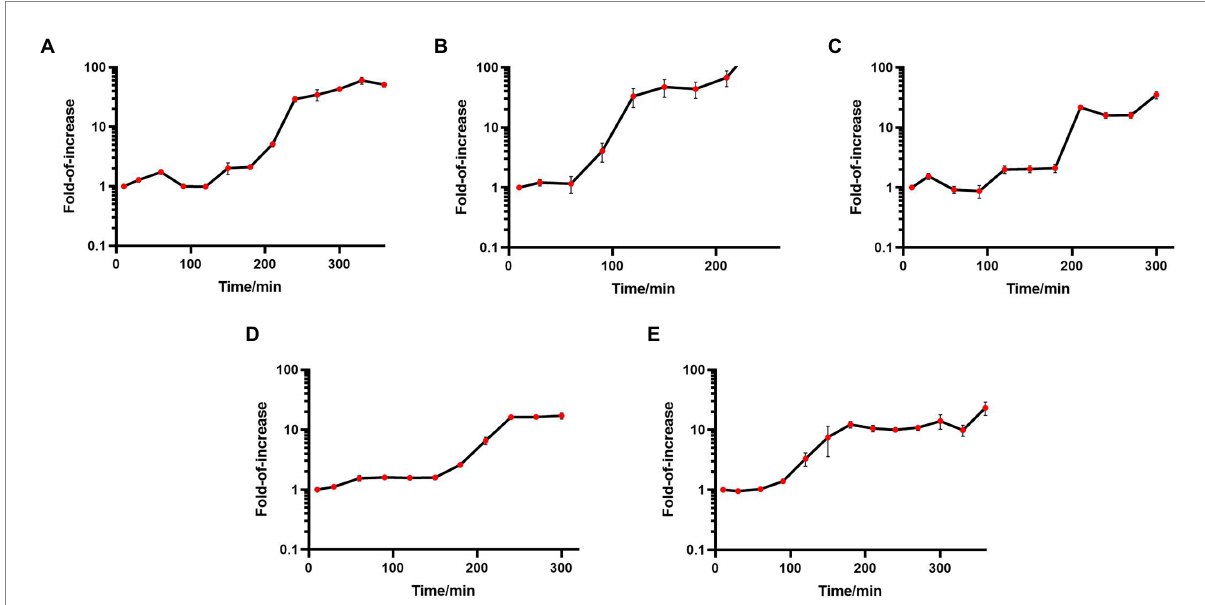
FIGURE 3 The one-step growth profile of phages JD-Fnp1 ~ JD-Fnp5. (A) JD-Fnp1; (B) JD-Fnp2; (C) JD-Fnp3; (D) JD-Fnp4; (E) JD-Fnp5. The x-axis shows the incubation time of phages with host bacteria; the y-axis shows the fold of increase of phage titers at different time points. Data are from three times independent experiments.